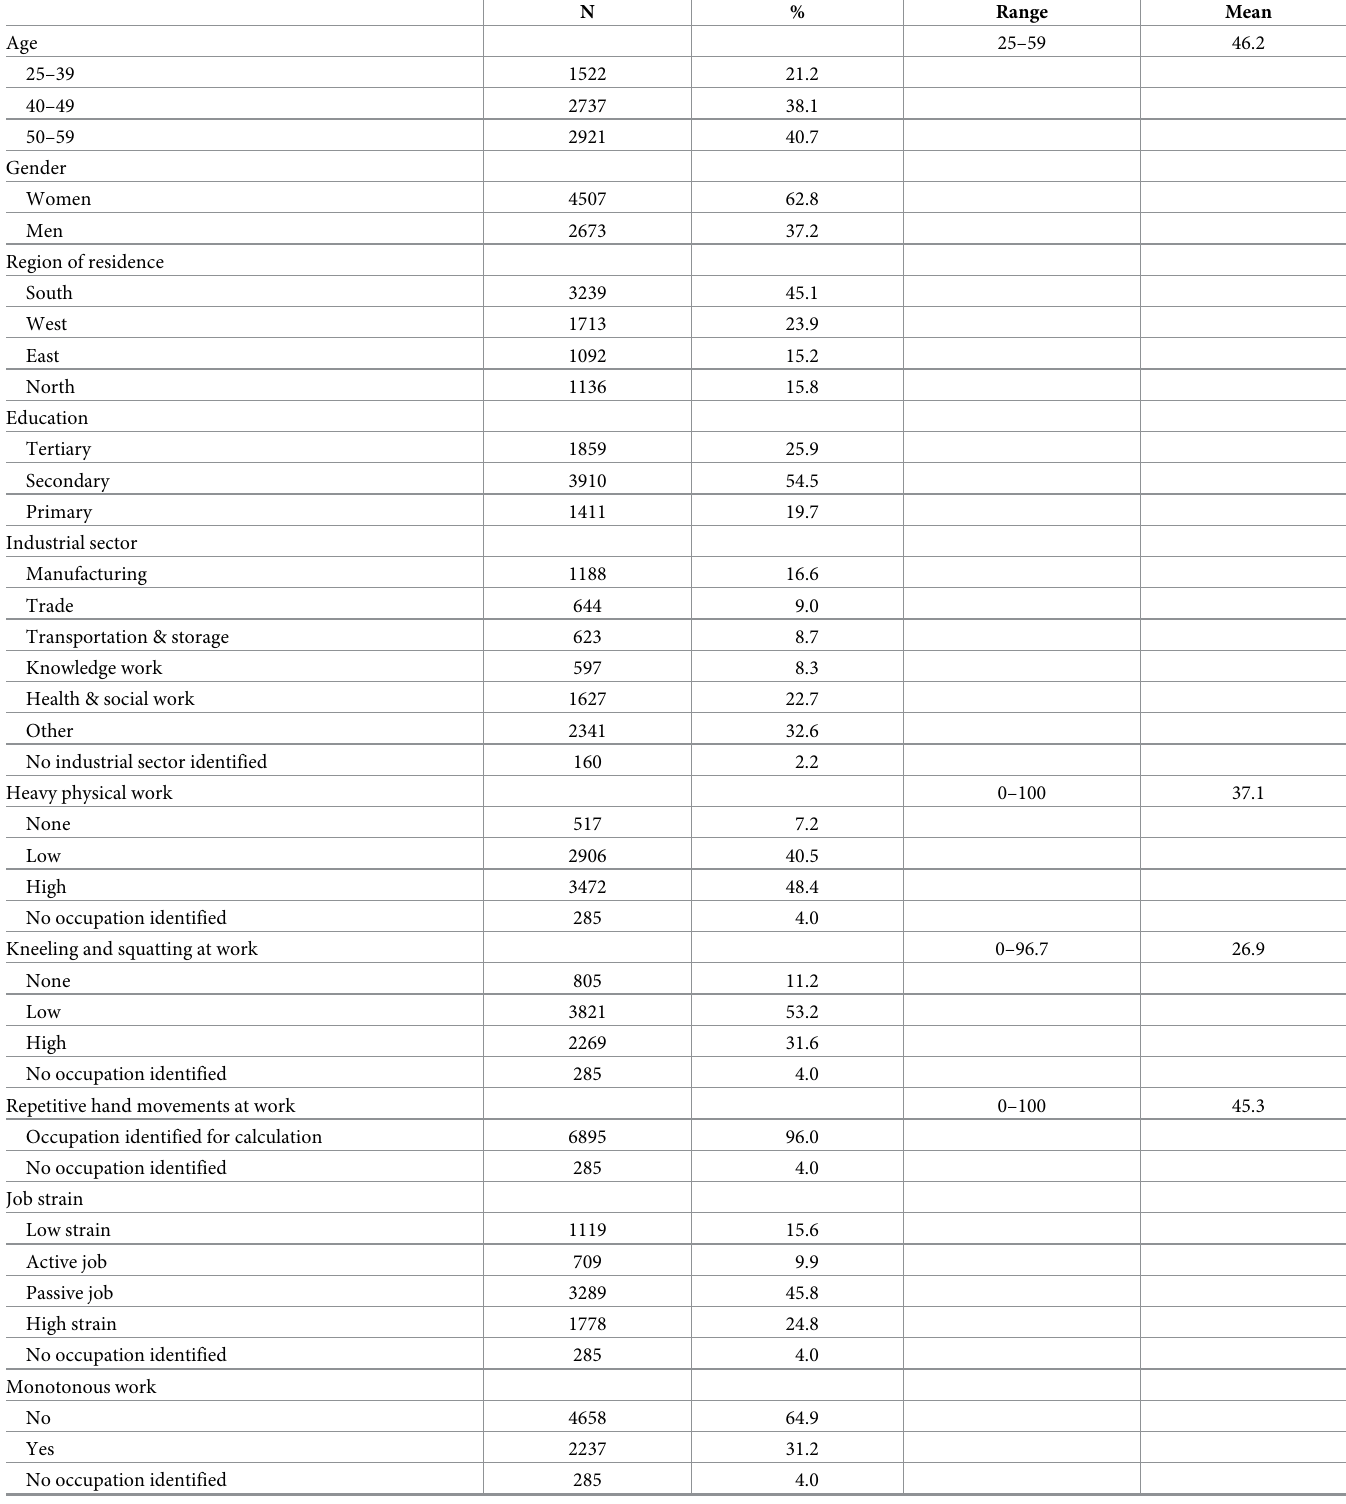
Table 1. Distribution of background characteristics among the vocational